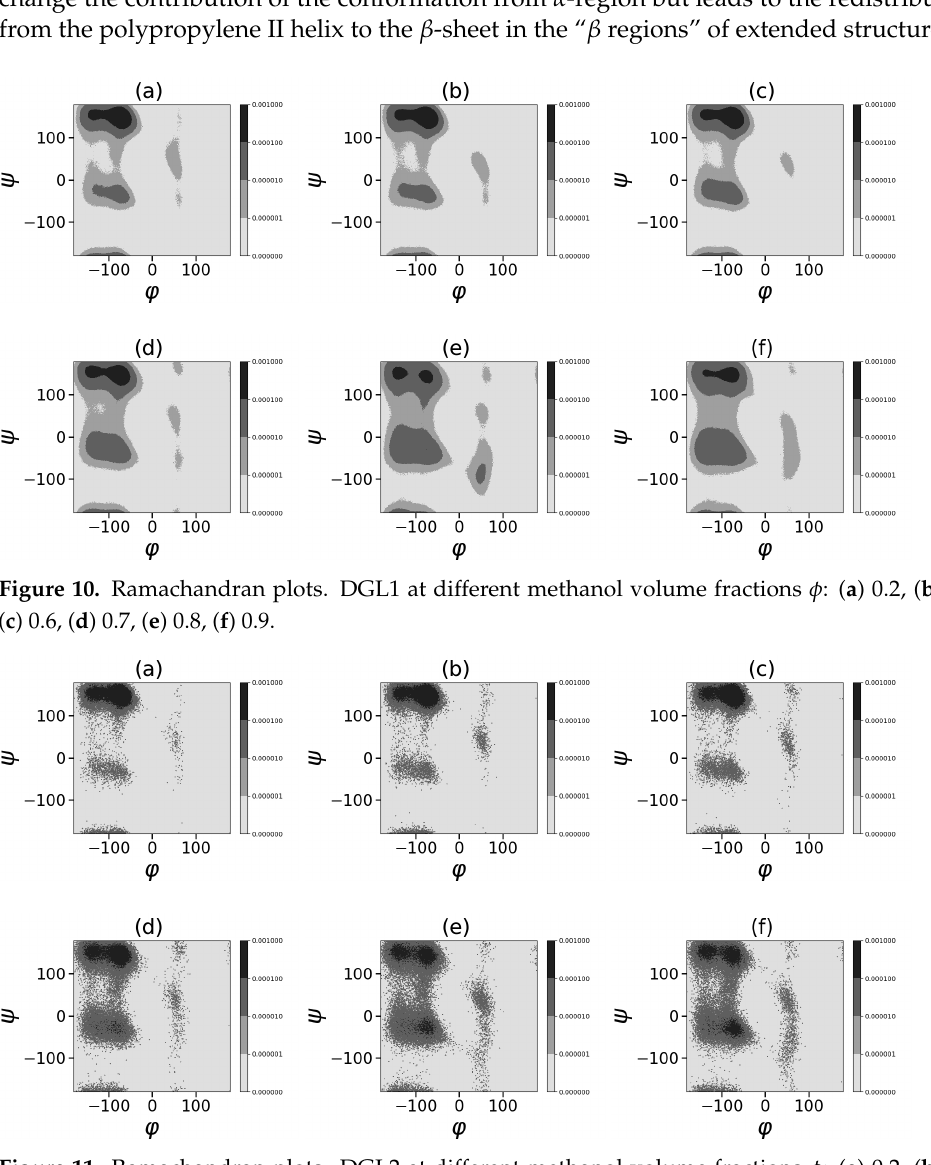
Figure 11. Ramachandran plots. DGL2 at different methanol volume fractions φ : ( a ) 0.2, ( b ) 0.4, ( c ) 0.6, ( d ) 0.7, ( e ) 0.8, ( f )